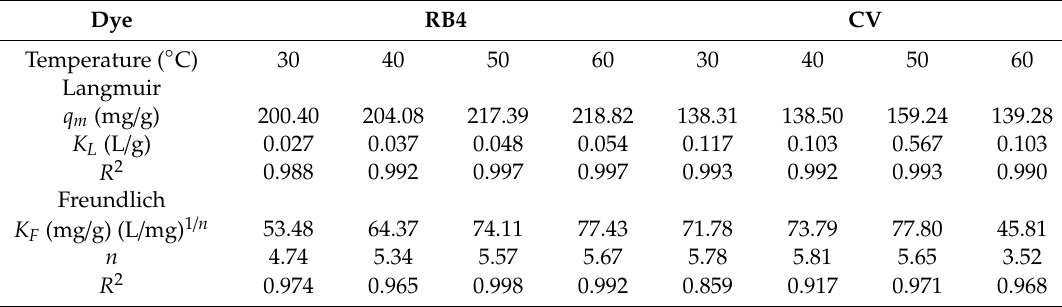
Figure 8. Adsorption capacity at various temperature of dye adsorption onto rice bran / SnO 2 / Fe 3 O 4 composite adsorbent: ( a ) RB4; ( b ) CV. Table 4. Isotherm parameters for dye adsorption onto rice bran / SnO 2 / Fe 3 O 4